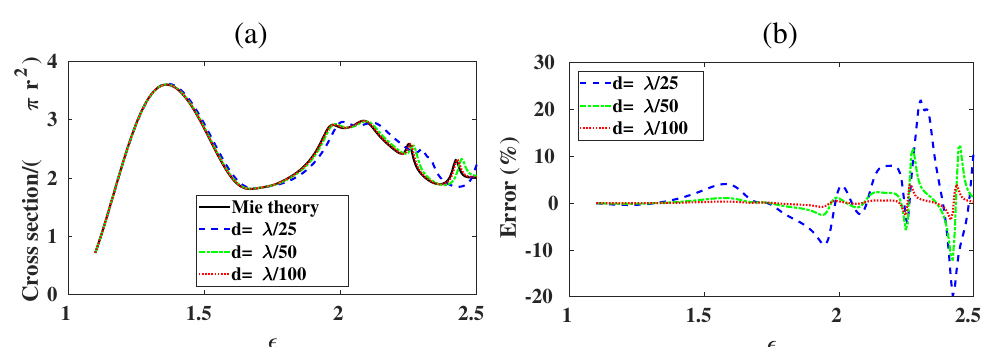
Figure 3. We study a sphere of radius r = 2 λ versus ε . ( a ) Extinction cross section with the Mie theory and DDA for different mesh size d . ( b ) Relative error on the extinction cross section between Mie theory and DDA for different mesh size d